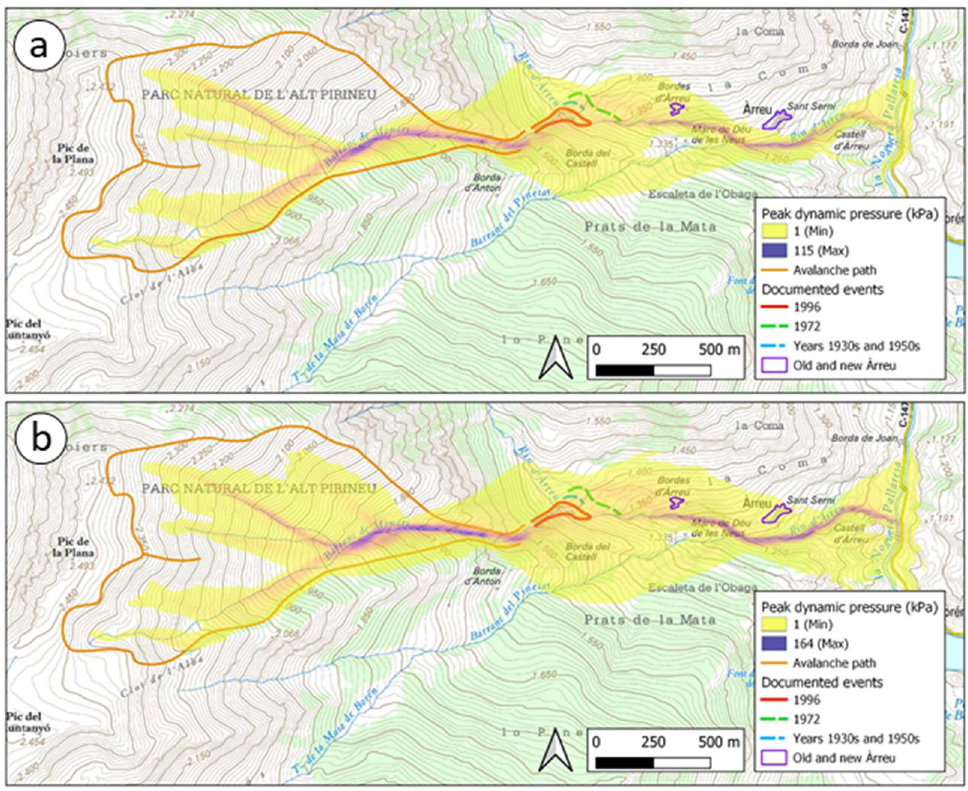
Figure 15. Dynamic simulation with the powder snow avalanche (PSA) module of SAMOS-AT: ( a ) Scenario of the medium-frequency release areas A5 and B4 and a release snow depth corresponding to a return period of 30 years (192 × 10 3 m 3 ). The peak pressure values at the western boundary of the hamlet were 7 kPa; ( b ) scenario of the full extent of the starting zones (A6 and B4) and a release snow depth corresponding to a return period of 30 years (603 × 10 3 m 3 ). The peak pressure values at the western boundary of the hamlet were 17 kPa.